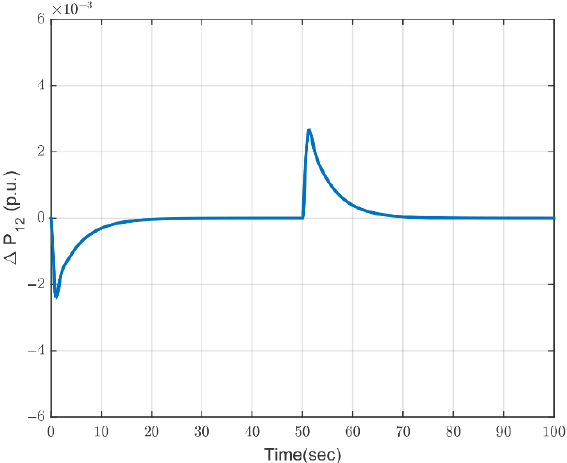
Figure 7. Tie-line power deviations of proposed LFC scheme during the unit step load disturbance.